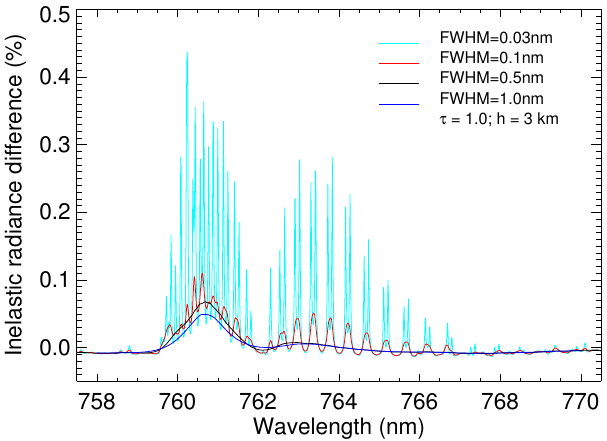
Fig. 8. Fractional inelastic radiance difference between aerosol loading with τ = 1.0 and aerosol-free case, SZA = 45 ◦ , at nadir, and surface reflectivity 0.3.